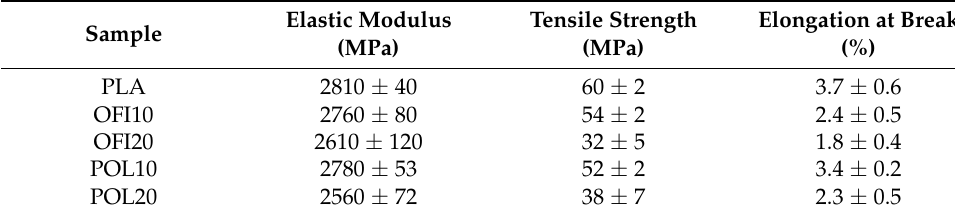
Table 3. Tensile properties of the 3D printed samples.